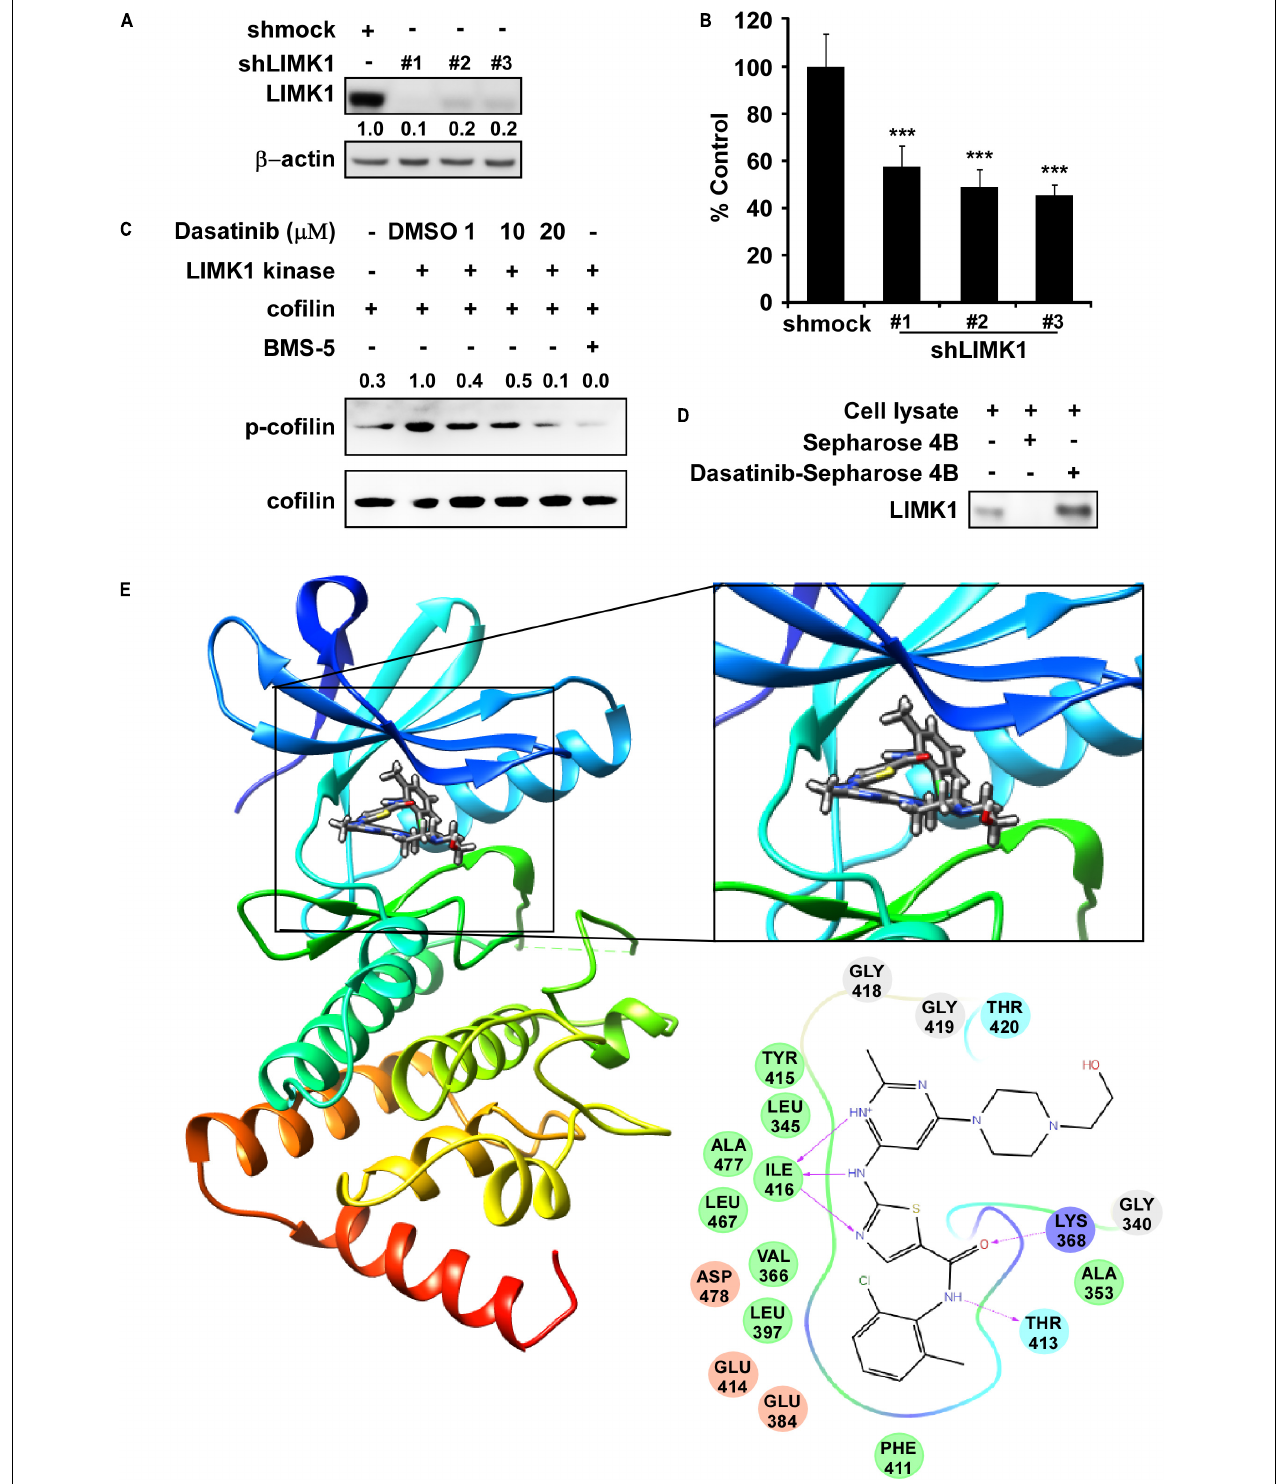
FIGURE 1 | LIMK1 is a target of Dasatinib. (A) The expression of LIMK1 after knocking-down LIMK. (B) Anchorage-independent colony formation in shmock- or shLIMK infected cells. ***, statistical significance ( p < 0.001) compared to shmock control. (C) Dasatinib inhibits LIMK1 activity and downregulates p-cofilin. (D) Dasatinib binds with LIMK1. (E) Dasatinib binds with LIMK1 (left); enlarged view of the binding location (right upper); interactions with amino acid sites (right down). LIMK1 structures are presented as ribbon representation and dasatinib is displayed in stick representation with hydrogen bonds.